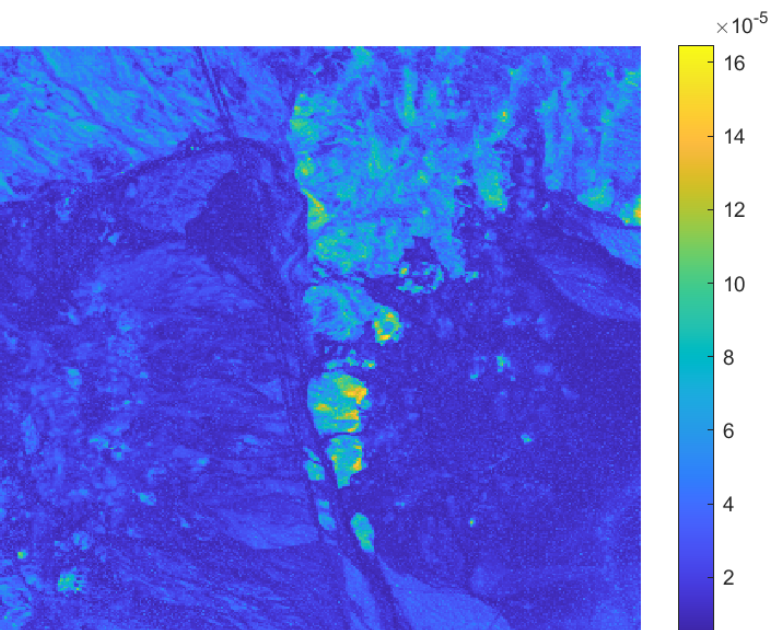
Figure 6. Per-pixel RMSE computed with the reconstruction of the Cuprite hyperspectral dataset. The mean RMSE value was 2.65 × 10 − 5